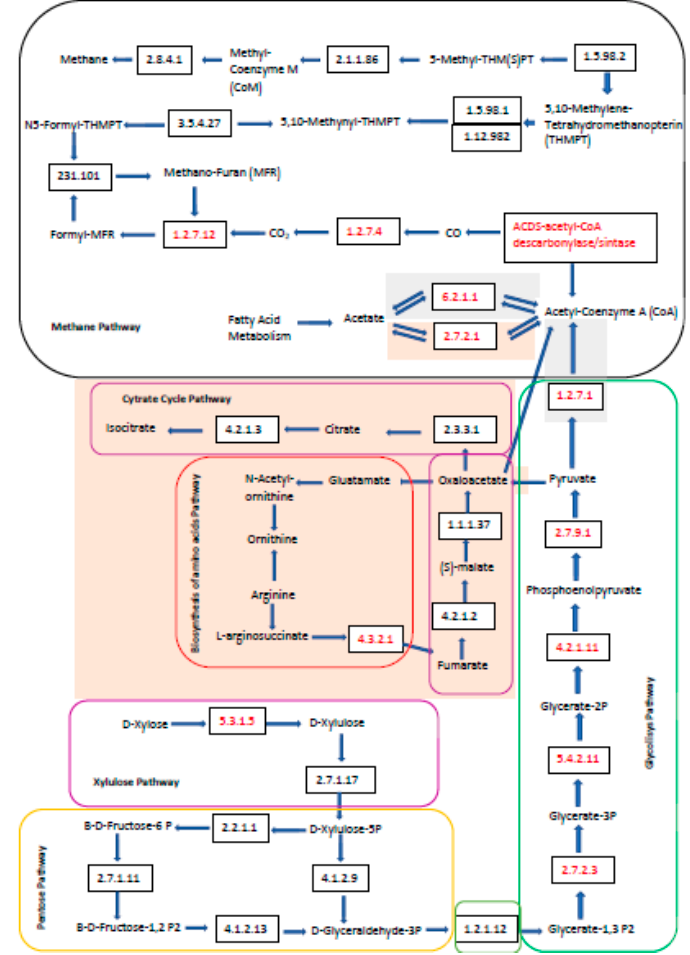
Figure 5. General proposed map of the metabolic pathways for 3 samples. SI: seed inoculum, R-NP: Nanoparticle’s reactor, R-CoAD: Co-digestion reactor. The red enzymes were detected in process. The white background is the metabolic maps for all samples, the light orange background maps are found for the sample R-NP and R-CoAD, and the map with a gray background is found in sample